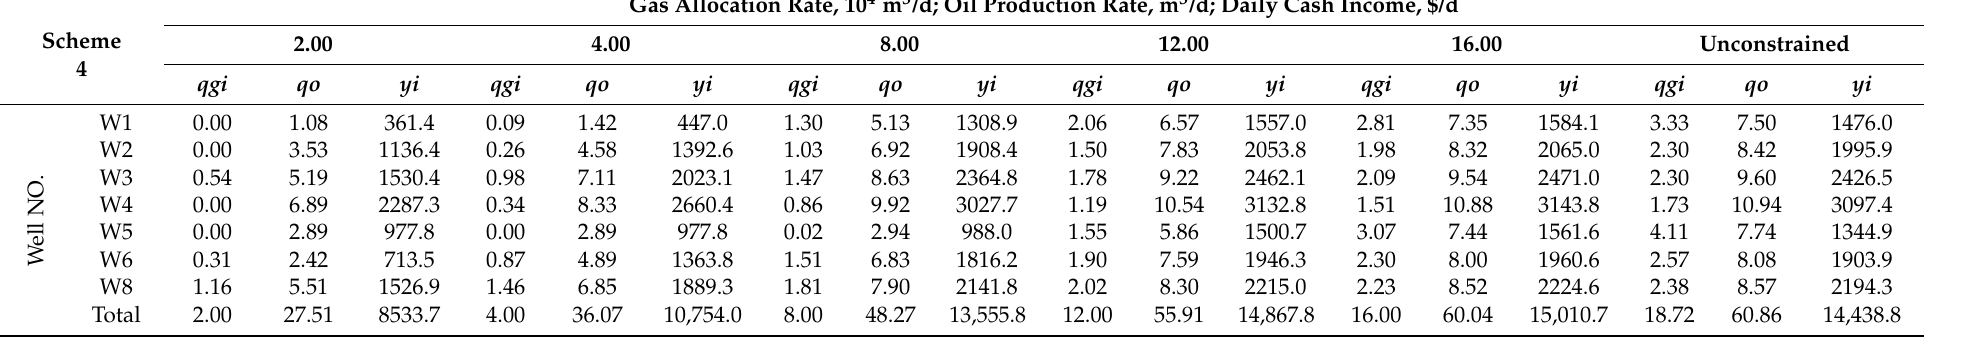
Table 7. Gas allocation result of various total injected gas rate of Scheme